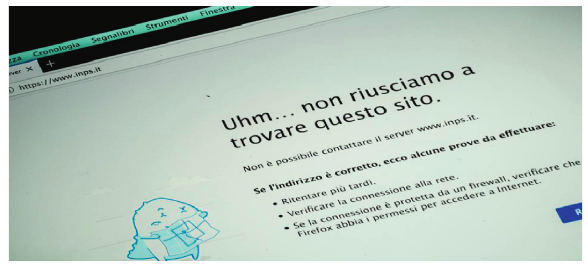
Figure 15: Italy’s social security website has been forced to shut down [30].